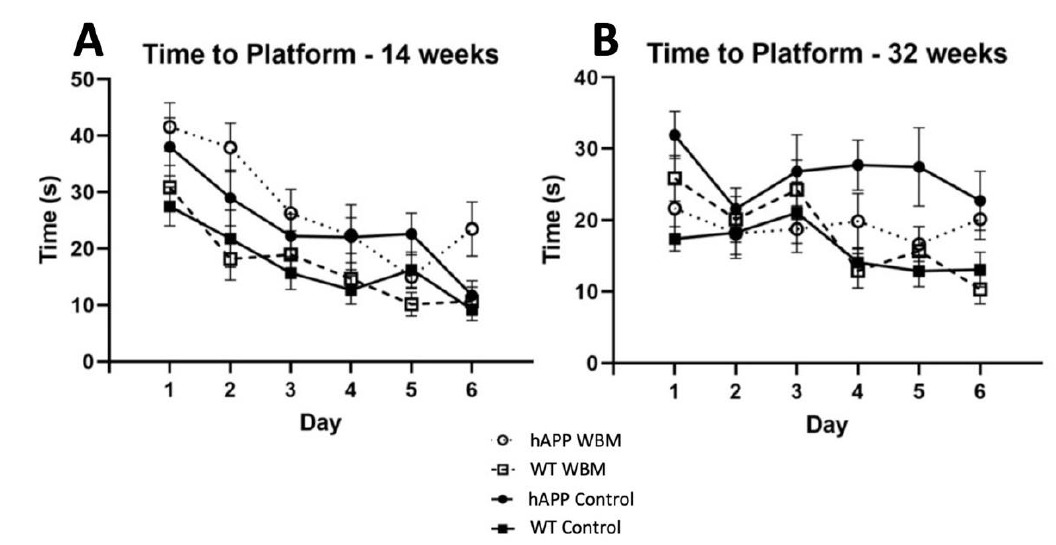
Figure 1. Morris Water Maze Performance ( n = 48). ( A ) For latency to find the platform in MWM at 14 weeks, there was a significant effect of day where mice found the platform more quickly as days progressed ( p < 0.001). ( B ) For latency to find the platform in MWM at 32 weeks, there was a significant effect of day, where mice of both genotypes found the platform faster as the days progressed ( p < 0.01). In addition, hAPP mice on the WBM diet had a shorter latency than hAPP mice on the control diet ( p <